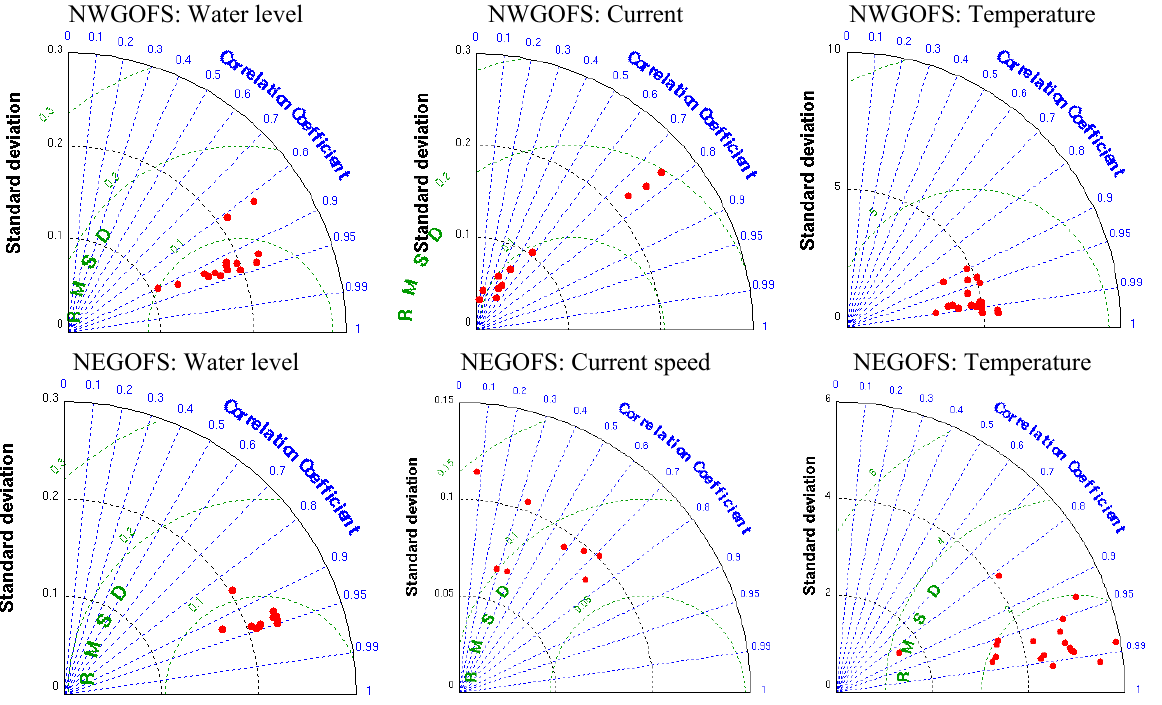
Figure 10. Taylor Diagrams of water level, current, and temperature for NWGOFS (upper row) and NEGOFS (bottom row). Standard deviation, Correlation coefficient, and The Root Mean Squared Deviation (RMSD) are presented in one diagram.